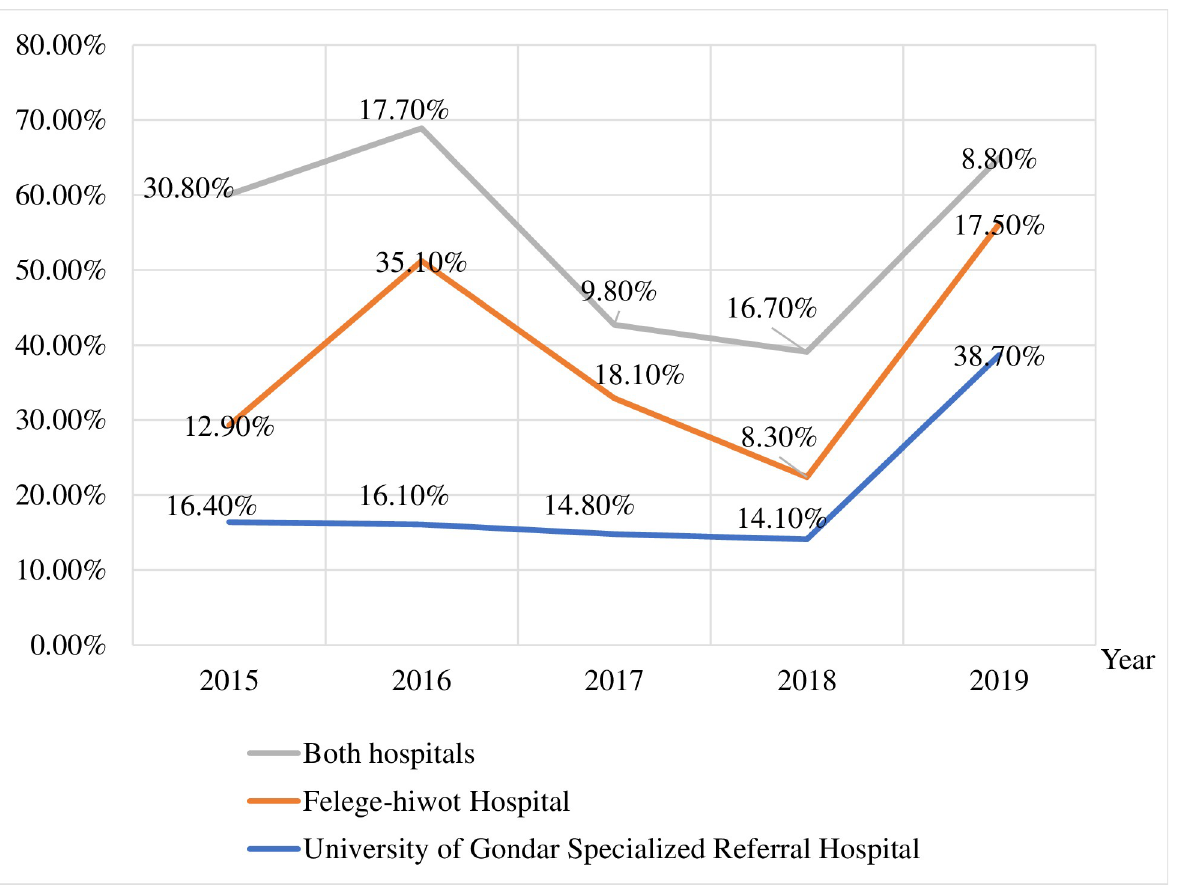
Fig 2. Year trend of hematological malignancy among study participants: Northwest Ethiopia.